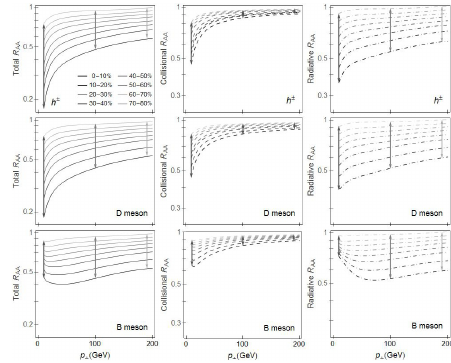
Figure 2. Explanation of suppression patterns for light (upper), D (middle) and B (lower row) probes. Left, central and right plots show, respec- tively, total, collisional and radiative R AA . Figure adapted from [4].